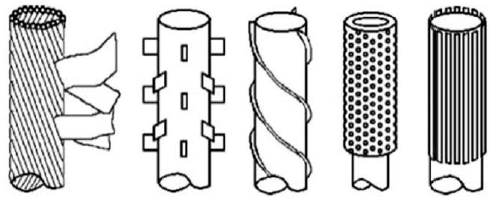
Figure 1. Helical strakes for controlling vortex-induced vibration.